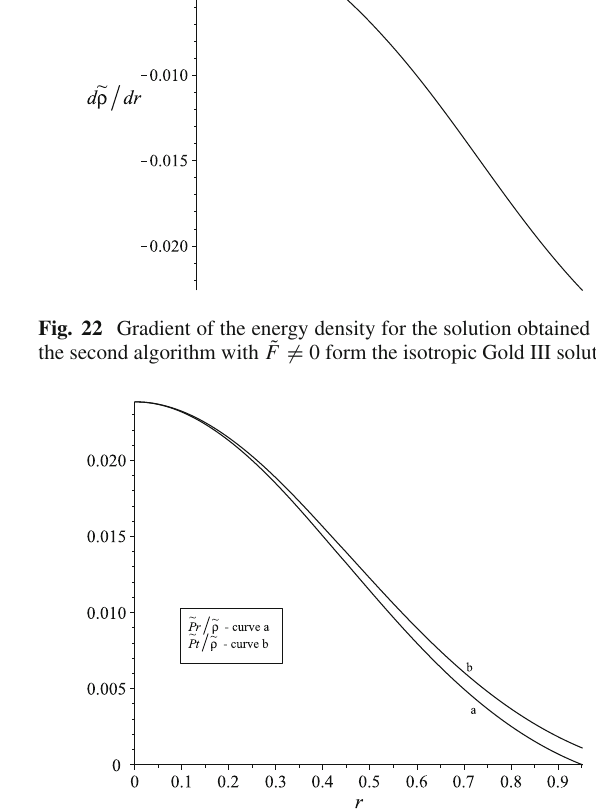
Fig. 23 Dominant energy condition for the solution obtained with the second algorithm with ˜ F (cid:9)= 0 form the isotropic Gold III solution